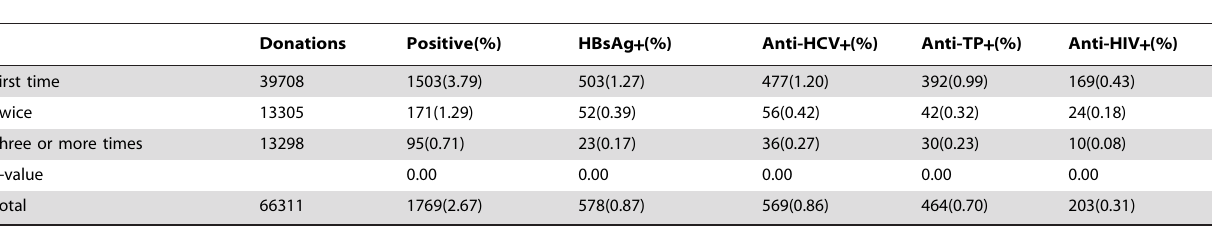
Table 5. Positivity rate of transfusion-transmissible infections, by donation frequency, n(%).